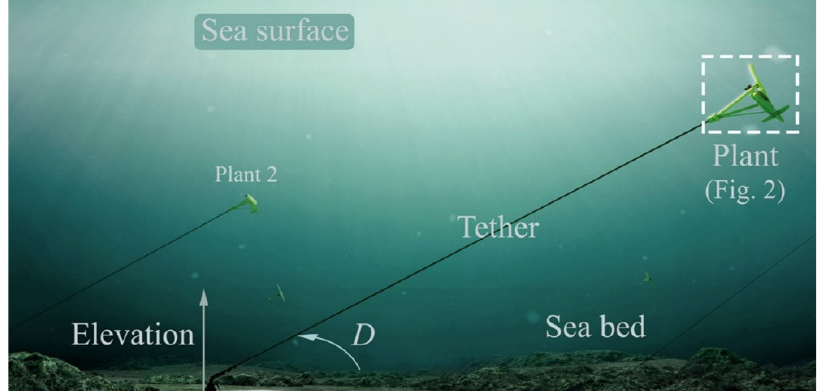
Figure 5. Diagram of the TUSK [90].